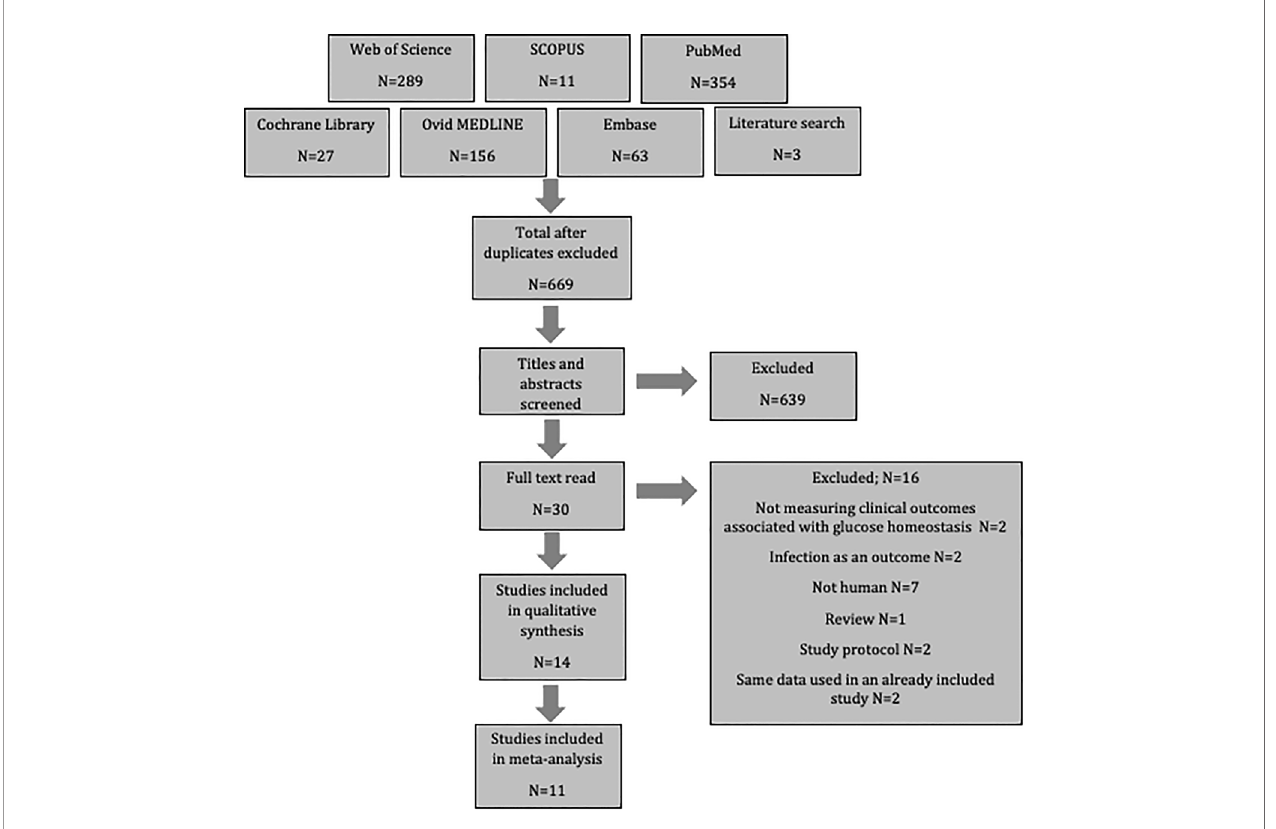
FIGURE 1 | Flow diagram of study